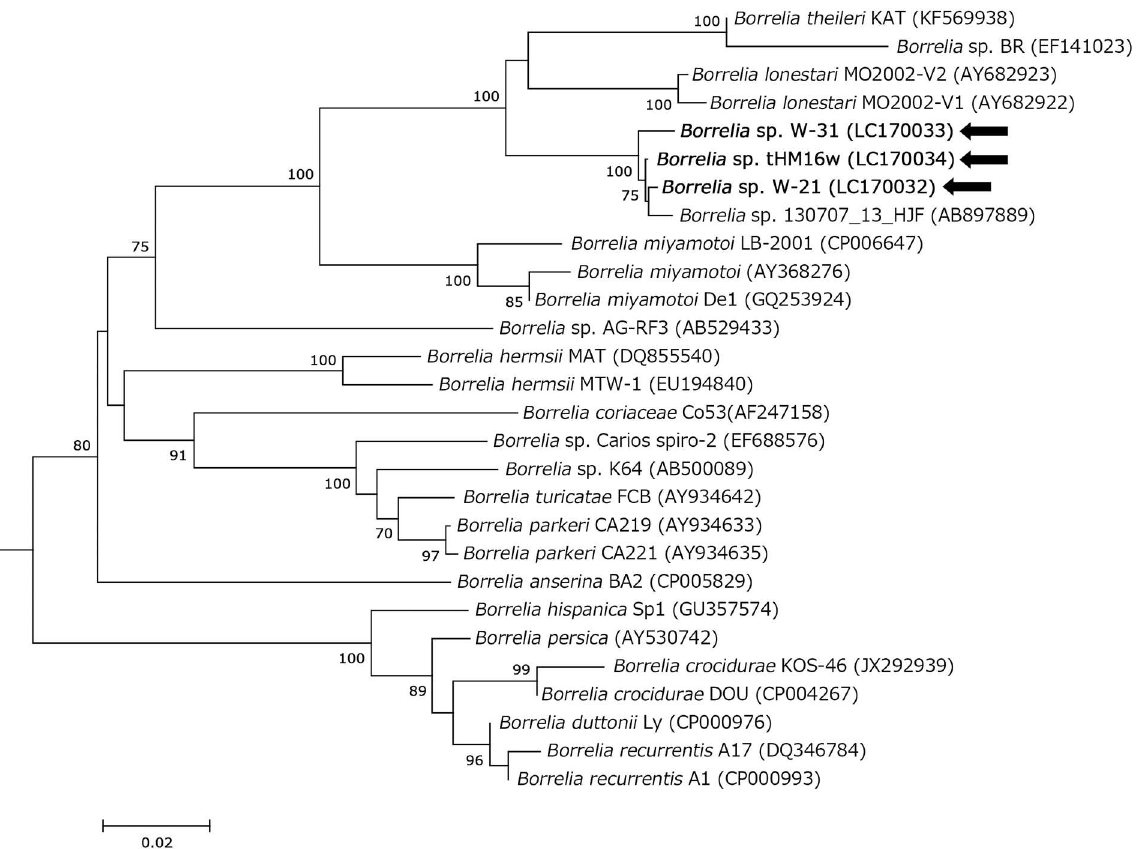
Fig 3. Phylogenetic analysis of glpQ in Borrelia spp. The tree was constructed using the neighbor-joiningmethod based on the Kimura two-parameter model. The phylogeneticbranches were supportedby > 70% accordingto the bootstrap analysis. The bar indicatesthe percentage of sequencedivergence. Borrelia sp. BF-16 (accessionno. AB529436), Borrelia sp. Tick98M (AB529432), Borrelia sp. TA2 (AB529434), and Borrelia sp. Tortoise14H1 (AB529431) were used as outgroups(data not indicated).Pointing arrows and bold type indicate the results obtainedin the present study. Numbers in parentheses represent GenBank accession numbers.